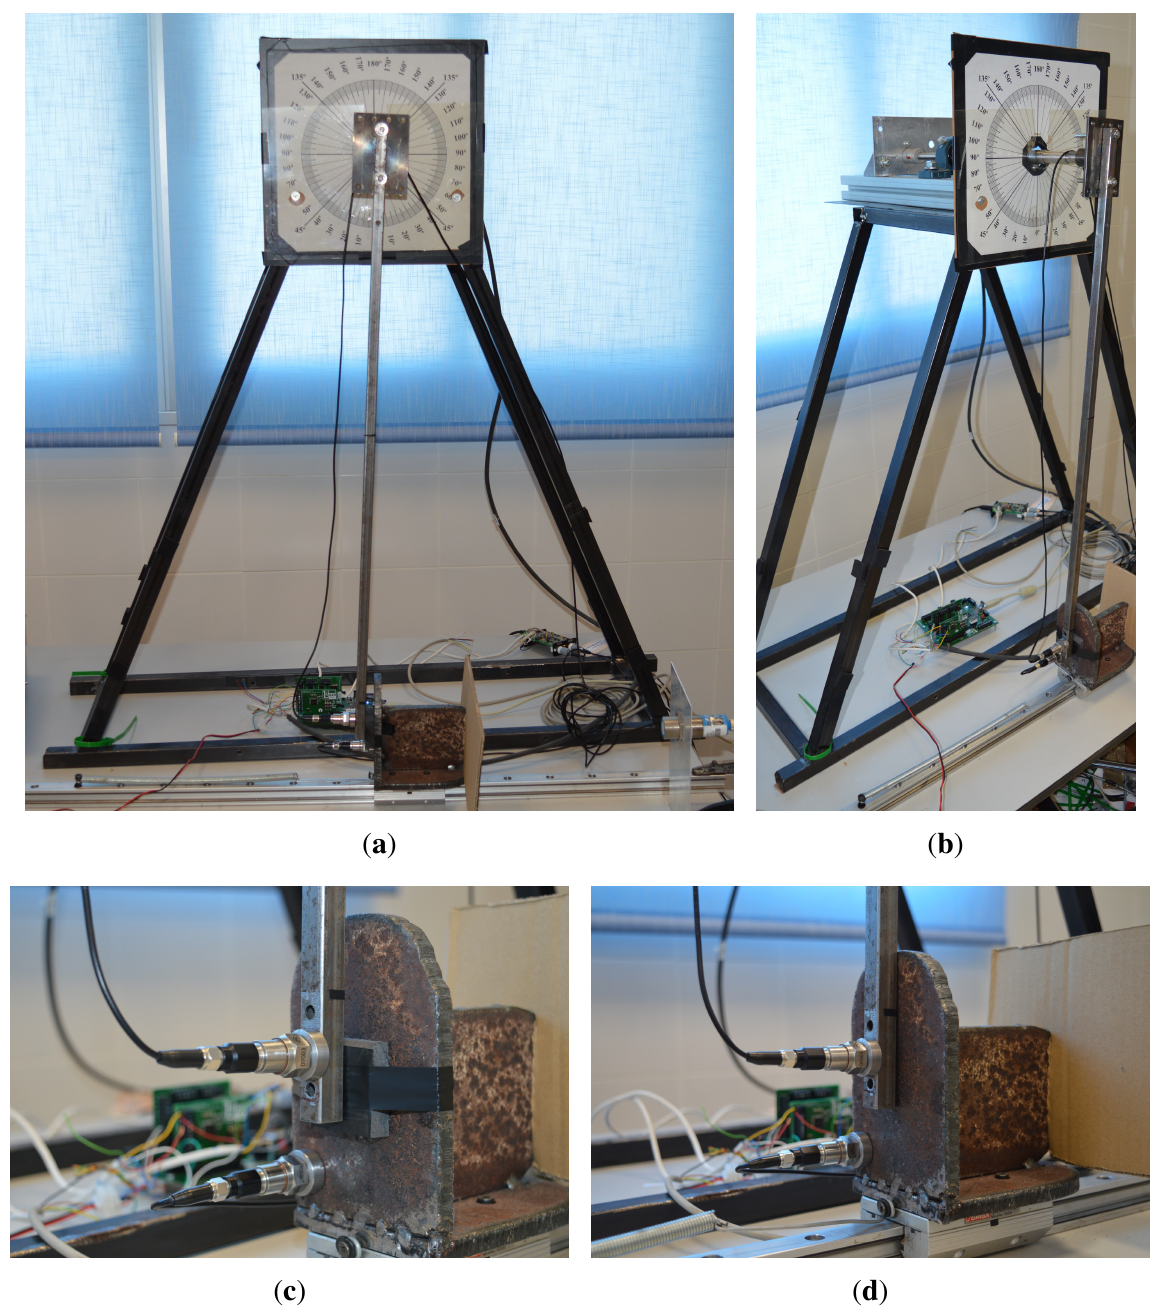
Figure 8. ( a , b ) Views of the impact testbed used in these experiments. The rigid rod is standing still in vertical position here, touching the mobile mass on a linear bearing at the bottom; ( c ) A close-up view of the two accelerometers, on the rod and the mass, with foam installed at the impact point; ( d ) The same view for the tests without protective